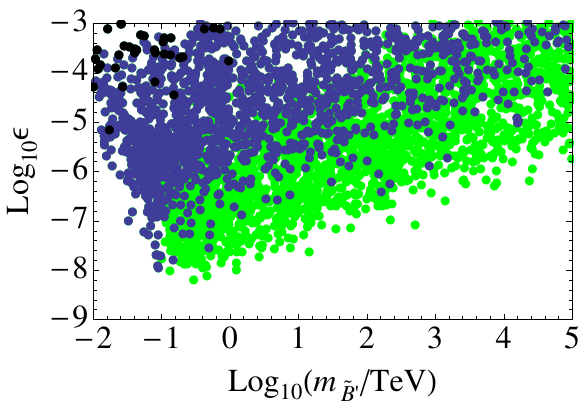
Figure 4 . Parameter space that produces a su(cid:14)cient amount of baryon asymmetry consistent with all constraints. Points are color coded according to m 0 =m ~ 100 (blue), or 100 < m 0 =m ~ < 1000 B 0